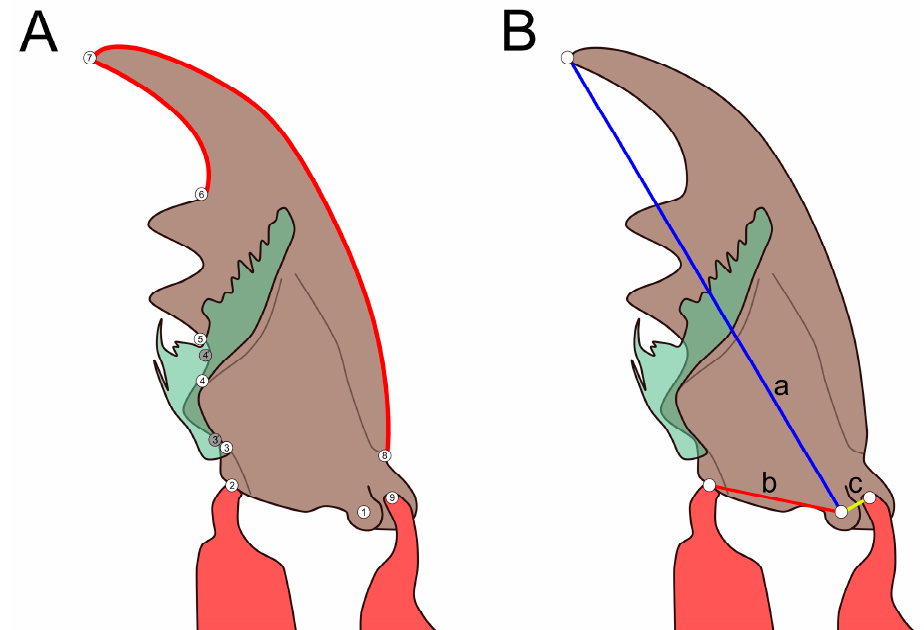
Figure 1. ( A ) Scheme of a measured mandible with registered landmarks (numbers). Ventral aspect of left mandible. Red lines with semilandmarks, 3 ′ as alternative landmark 3, 4 ′ as alternative landmark 4 in cases where a brush-like prostheca was not present (cf. Rugilus spp.), ( B ) Scheme of registered landmarks with levers, ventral view of left mandible, a = mandible length, blue; b = in-lever, red; c = out-lever, yellow.